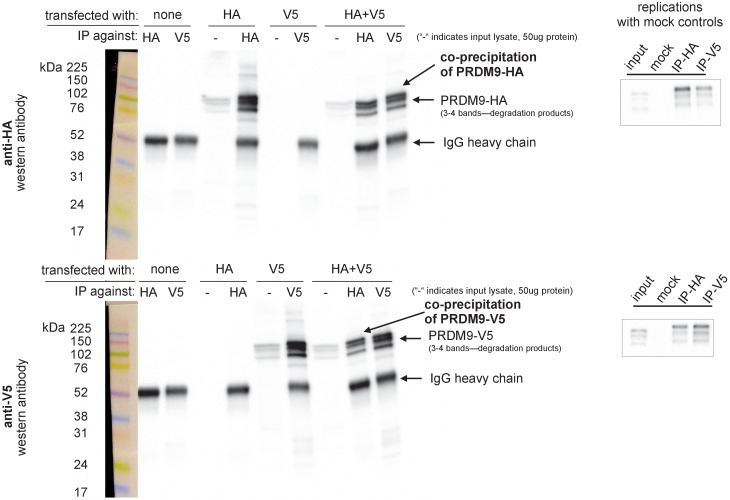
Confirmation of PRDM9 multimer formation.Left: Western blots illustrating controls and experimental results. Samples were split and run on two blots separately, one imaged using an anti-HA antibody (upper) and one using an anti-V5 antibody (lower). Exposure time was 4 min. Ladder lanes are overlaid on the left, with approximate sizes in kiloDaltons noted. Lanes are labeled according to which full-length Human construct (HA or V5) was used, as well as which antibody was used for immunoprecipitation. IgG heavy chains are visible around ∼50 kDa, while the Human allele is visible as a band around ∼100 kDA with two or three smaller bands beneath it, likely representing degradation products (Grey et al., 2011; Cole et al., 2014). ‘-' is a short-hand label for input lanes, for which 50 μg of input chromatin was loaded in each well. The first six lanes demonstrate the specificity of the antibodies and their lack of cross-reactivity. The last two lanes show the co-IP experimental results confirming multimerization. Right: Two independent replicates were performed to confirm the formation of multimers with the full-length human constructs, using IgG mock control lanes to rule out nonspecific co-precipitation. Images were cropped to include only the PRDM9 bands. Input lane bands appear to have run lower than expected due to the use of a higher concentration of loading buffer in the IP lanes, an issue which was avoided in subsequent experiments.